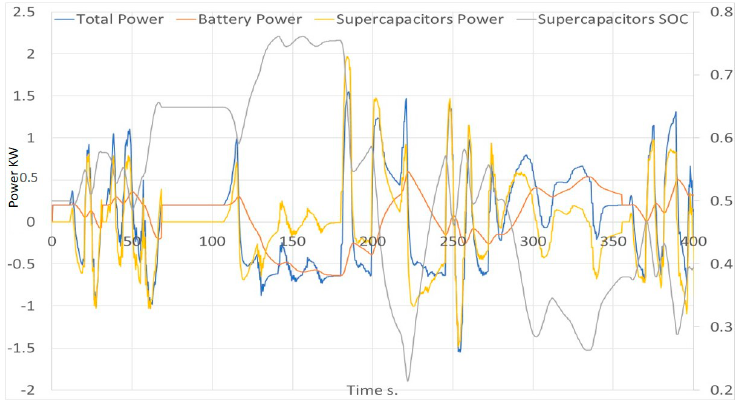
Figure 14. Simulated electrical power requested, battery and UCs power during the WLTC Class 1 driving cycle for the hybrid